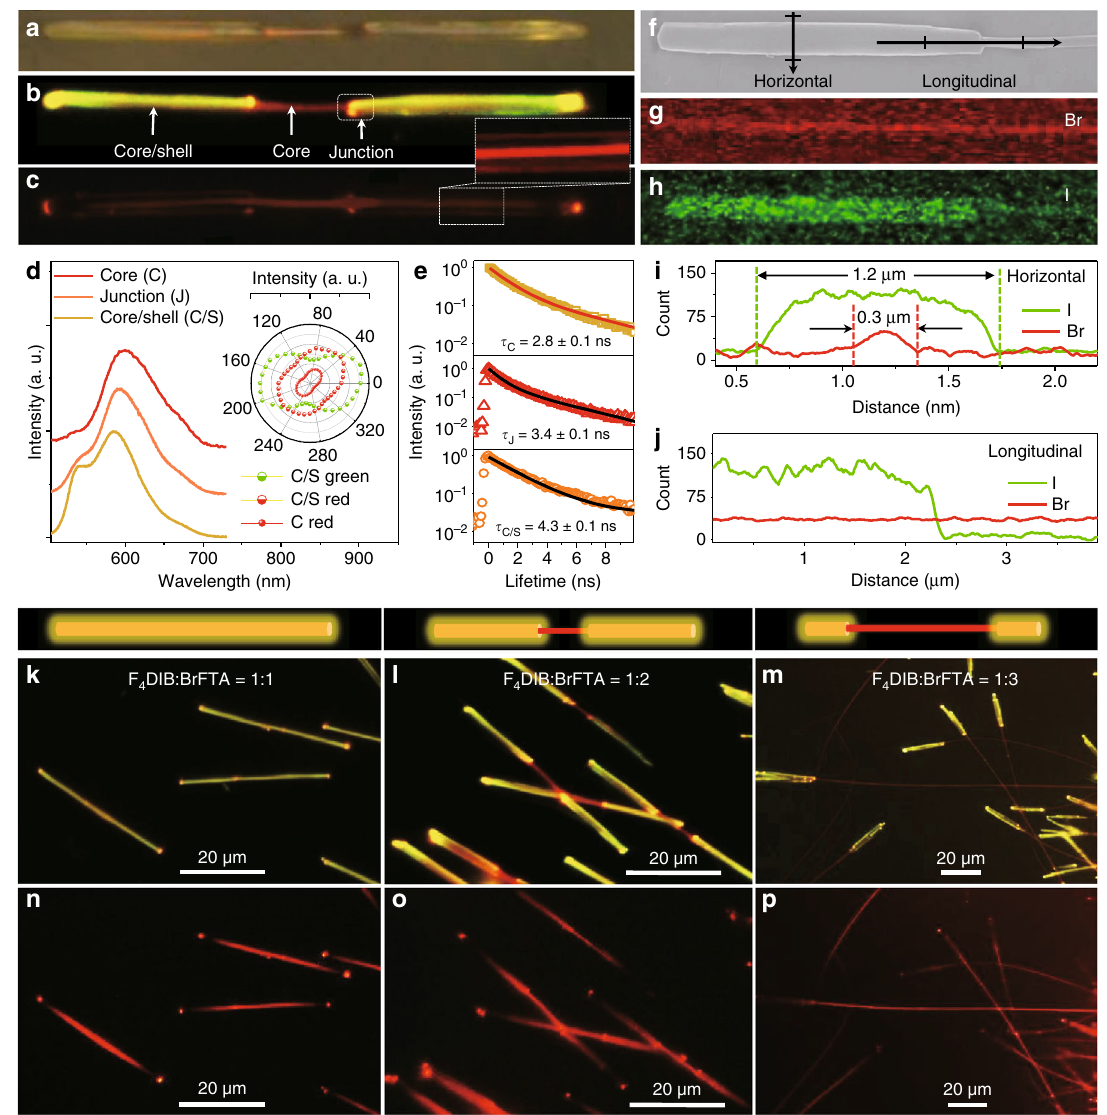
Fig. 4 Structure and optical characteristic of C/S-NWs. a Optical image and corresponding FM images under excitation by b the UV band and c green-light of an individual DB-C/S-NW with scale bar of 5 μ m. d Spatially resolved PL spectra and e PL decay curves collected from different locations marked in ( b ). Inset of d : corresponding polar image of the peak intensities. f The SEM image of a typical DB-C/S-NW and the corresponding EDS mapping for g Br and h I; scale bar: 5 μ m. The element I and Br distribution along i vertically and j parallel directions marked in d 1 . FM images of DB-C/S-NWs based on different ratio between the halogen bond acceptor of F 4 DIB and the hydrogen bond acceptor of BrFTA: k , n 1:1, l , o 1:2 and m , p 1:3; scale bar: 20 μ m. The excitation source for ( k – m ) and ( n – p ) are the UV light and green-light,